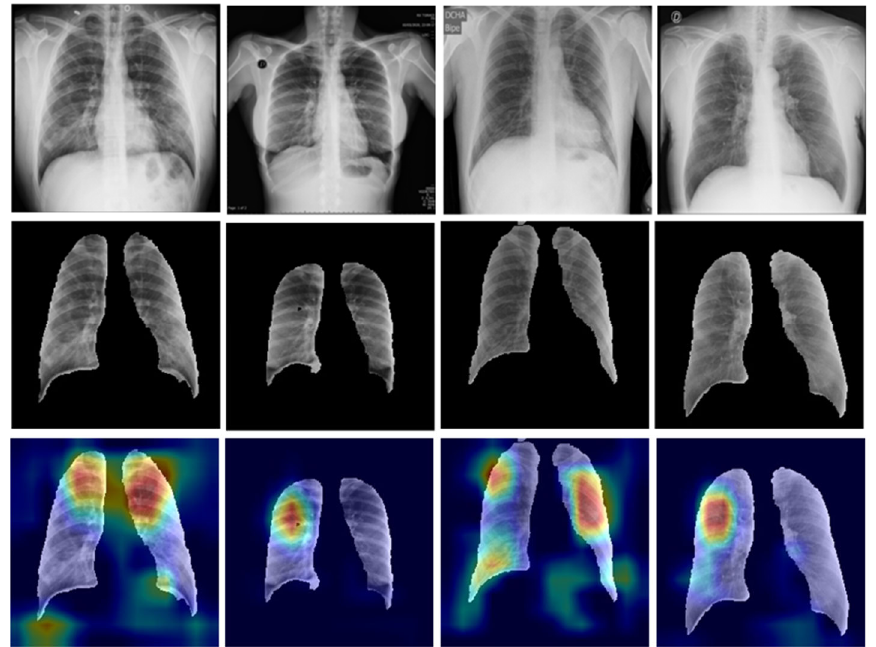
Figure 24. Example of correctly classified COVID-19 chest X-ray images; top row: original COVID-19 infected chest X-ray images, middle row: segmented masks, bottom row: corresponding heat map images.